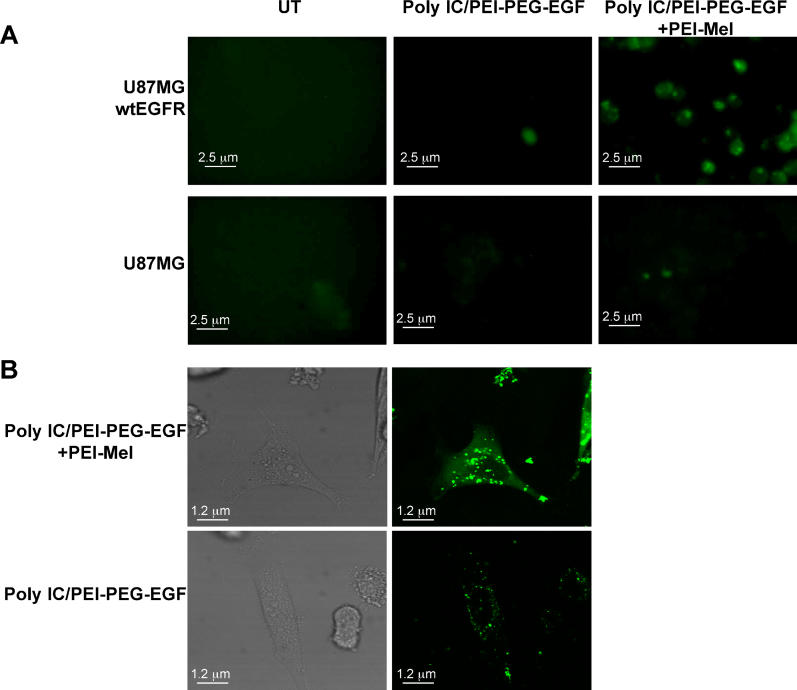
Distribution of the ComplexesCells were seeded into 6-cm plates at a density of 300,000 cells in 2 ml of medium per plate and grown overnight. Cells were then transfected with the fluorescently labeled poly IC (5 μg/ml) using the indicated conjugates. After 4 h, cells were analyzed by fluorescent microscopy (Methods) for selectivity of the transfection (A) and intracellular distribution of the complex in the U87MGwtEGFR cells (B).